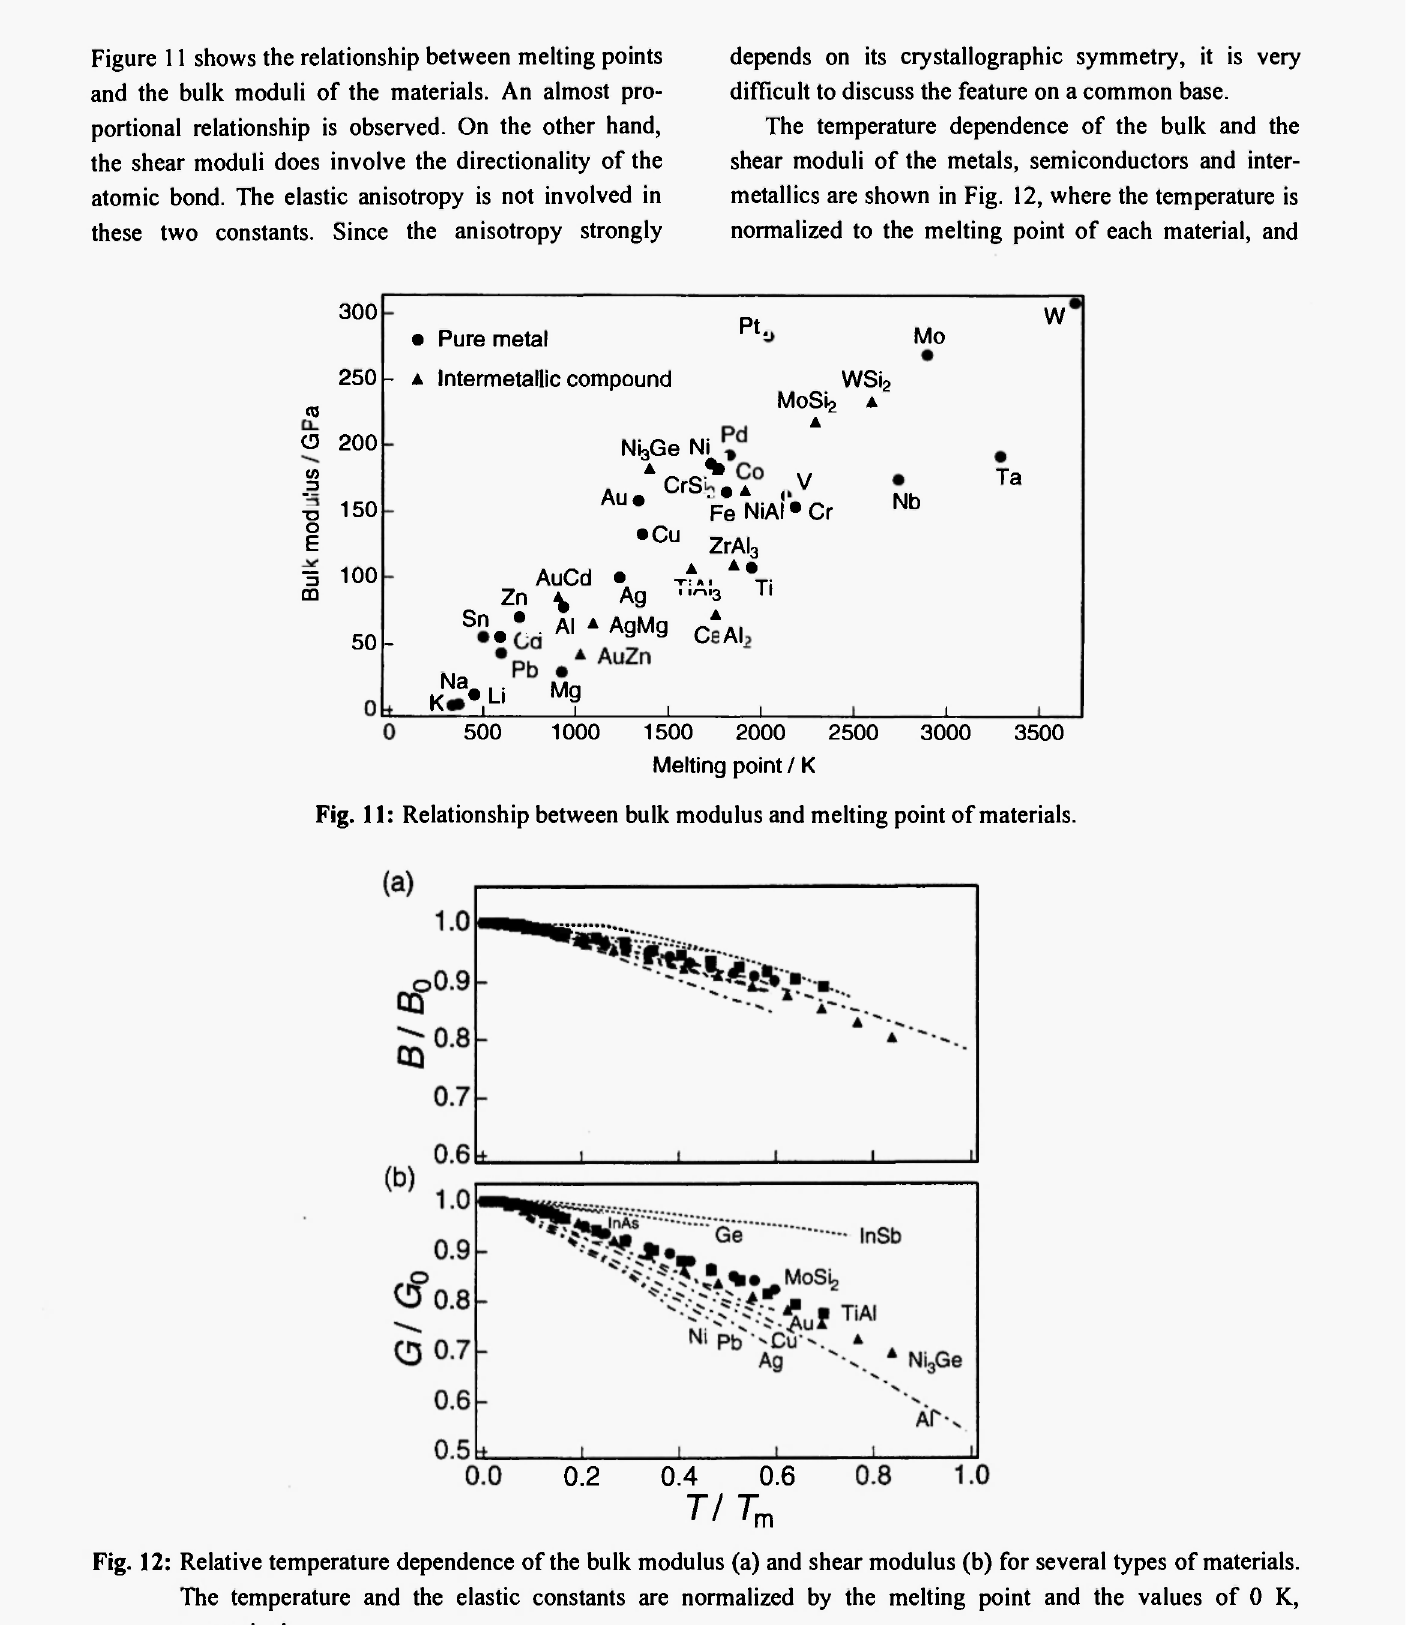
Fig. 12: Relative temperature dependence of the bulk modulus (a) and shear modulus (b) for several types of materials. The temperature and the elastic constants are normalized by the melting point and the values of 0 K,